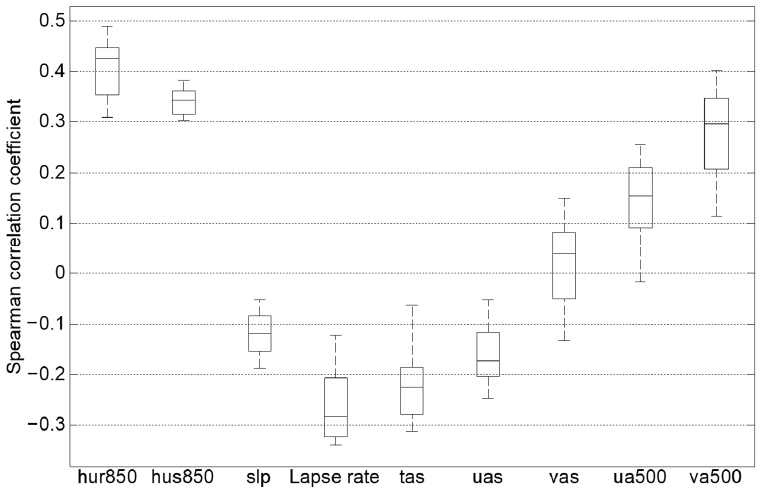
Figure 4. Forecast factor preference results of the summer precipitation downscaling model for the Beijing station. Except for the three variables (slp, uas, and vas), the other variables have a significant correlation with precipitation.